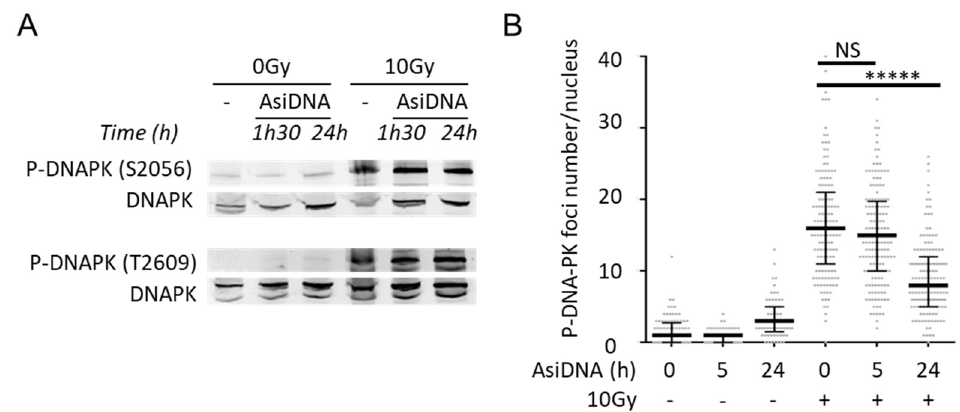
Figure 6. DNA-PK autophosphorylation and inhibition of its recruitment by AsiDNA. ( A ) Autophosphorylation of DNA-PK at S-2056 and T-2609 in MRC-5sv after different incubation times with AsiDNA followed or not by 10Gy irradiation. ( B ) Quantification of S2056-DNA-PK foci per nucleus in SK28 by immunostaining and microscopy analysis after various times of AsiDNA treatment and followed or not by 10 Gy irradiation. Foci were monitored 1 h after irradiation. Mann-Whitney test: